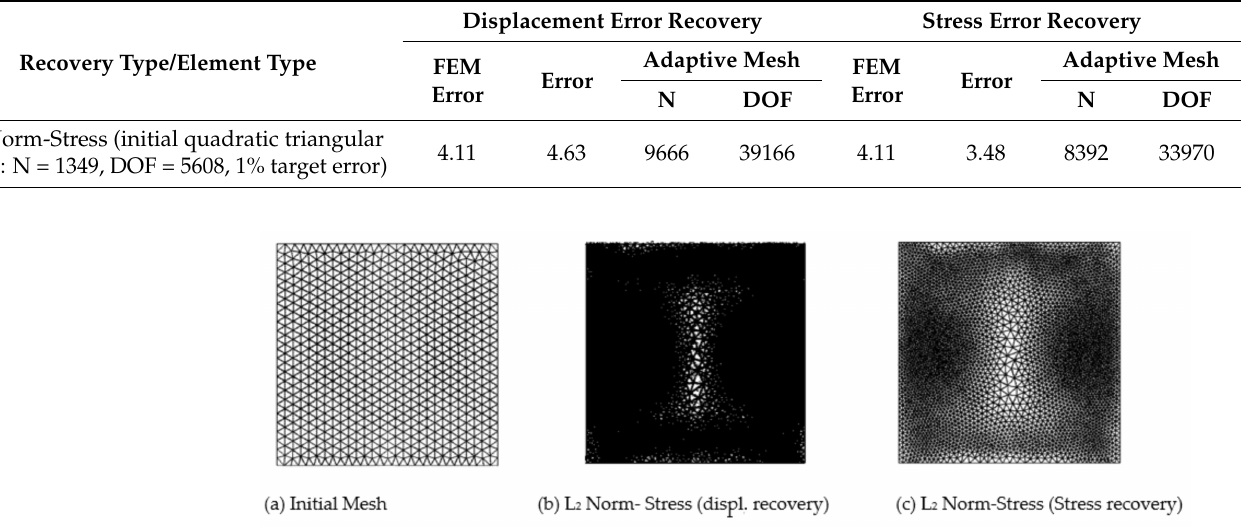
Figure 9. Adaptive mesh required for 1% target error (L 2 -Norm) incompressible elastic square plate example solution variables considering displacement and stress recovery techniques (Initial regular quadratic triangular mesh: N = 1349, DOF =